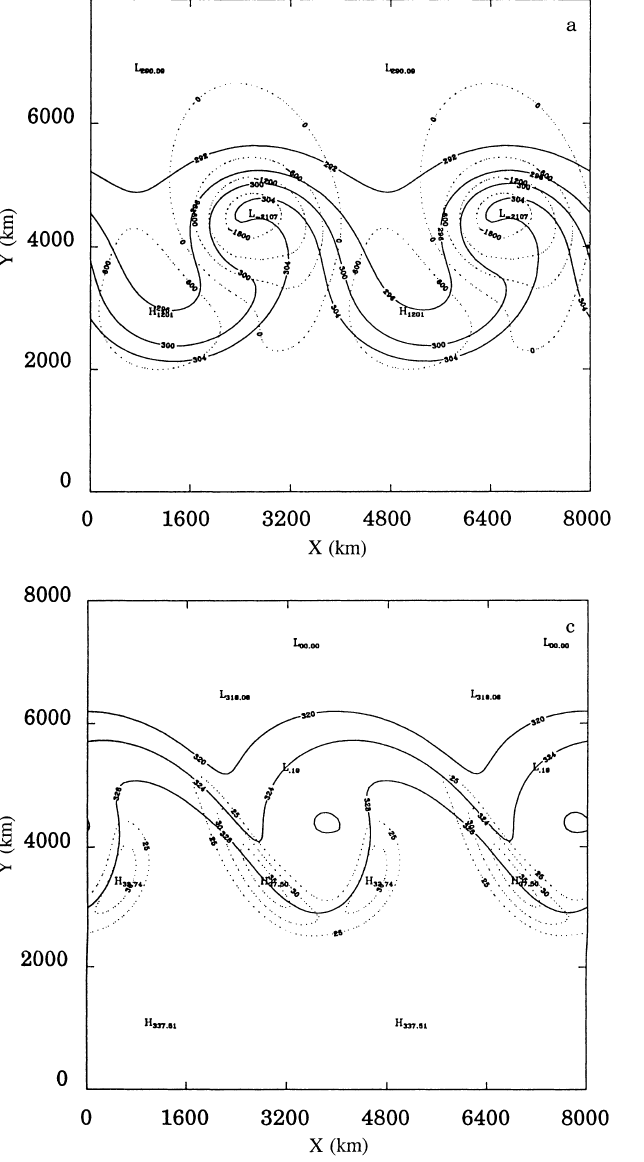
computed with the reference model at day 8. c potential temperature at 7000 m (solid lines 4K) and wind speed at 9000m (cid:133) dashed ; 5ms (cid:255) 1 (cid:134) computed by Meso-NH at day 10; d potential temperature at 7000m (cid:133) solidlines ; 4K (cid:134) and wind speed at 9000m (cid:133) dashed ; 5ms (cid:255) 1 (cid:134) com- puted by the reference model at